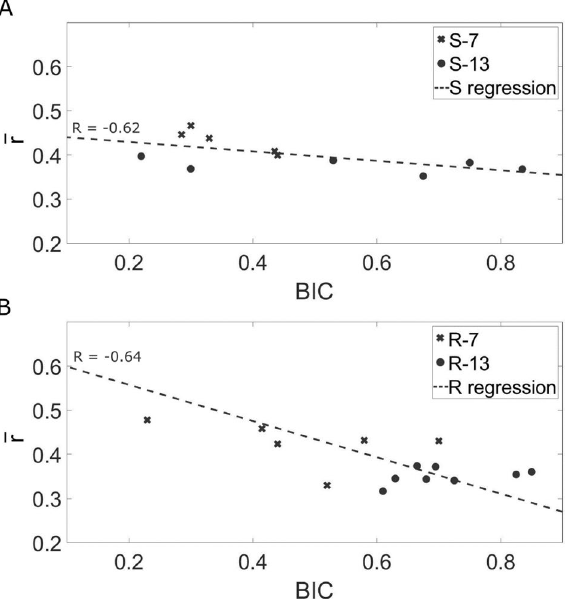
Figure 9. Variation of the ratio r as a function of the BIC values for all samples from the four groups of the S series ( A ) and the R series ( B ). The markers (see legend) correspond to the experimental results and the dotted lines to their linear